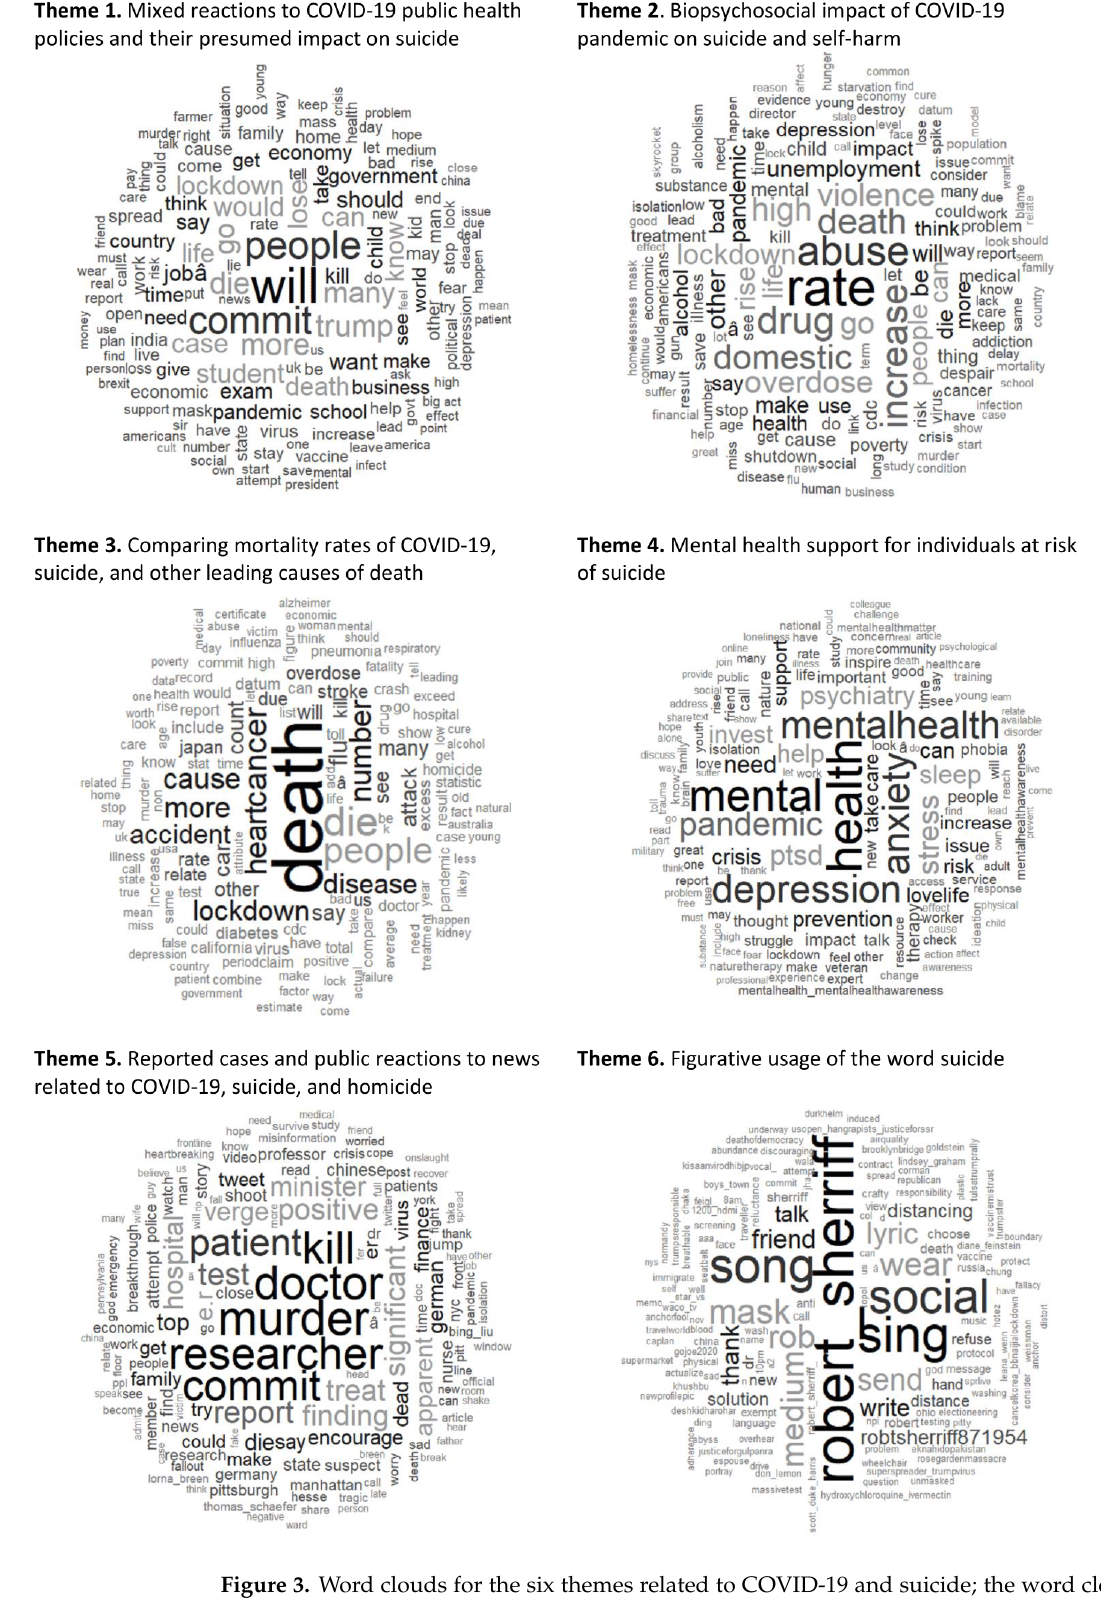
Figure 3. Word clouds for the six themes related to COVID-19 and suicide; the word clouds have been weighted using term frequency–inverse document frequency (TF-IDF) to give more emphasis to words that are unique to each tweet.